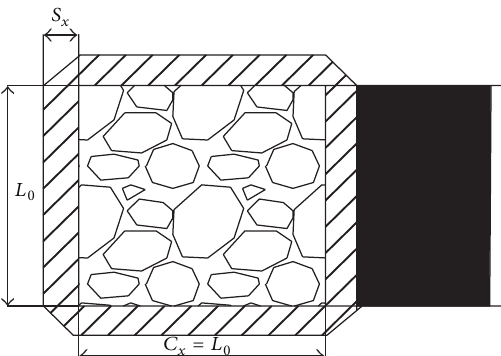
Figure 5: Abutment pressure distribution in the stope.